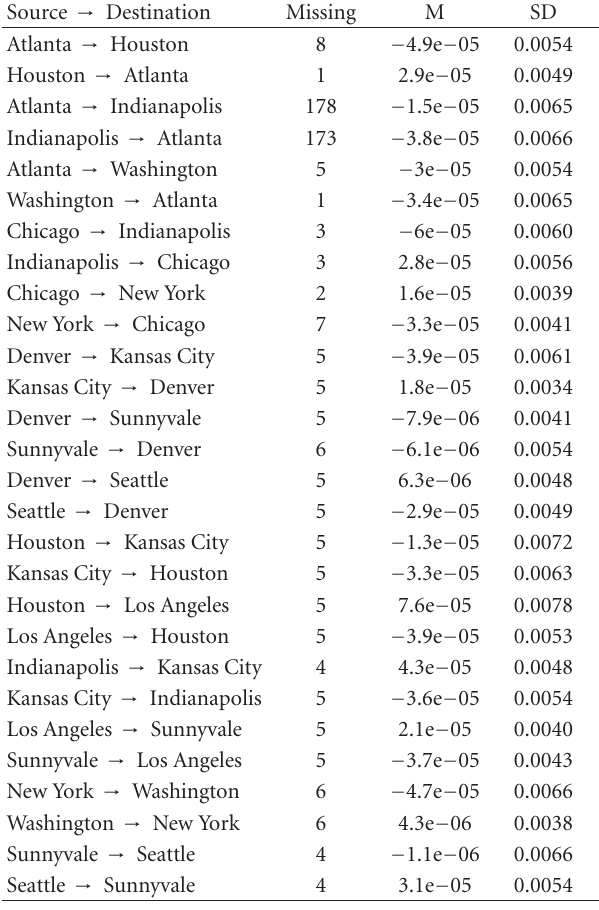
Table 1: Error sizes: “missing” refers to the total number of missing data points from either end of the link (out of 23,498 entries). M and SD are the mean and standard deviations of the relative error calculated as described in the